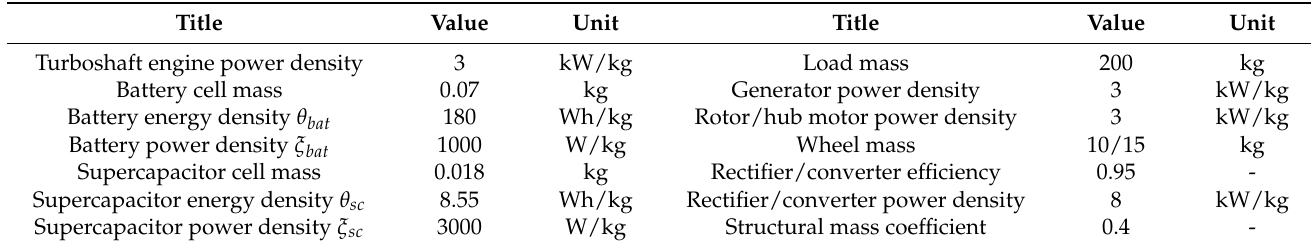
Table 3. Historical statistics of components’